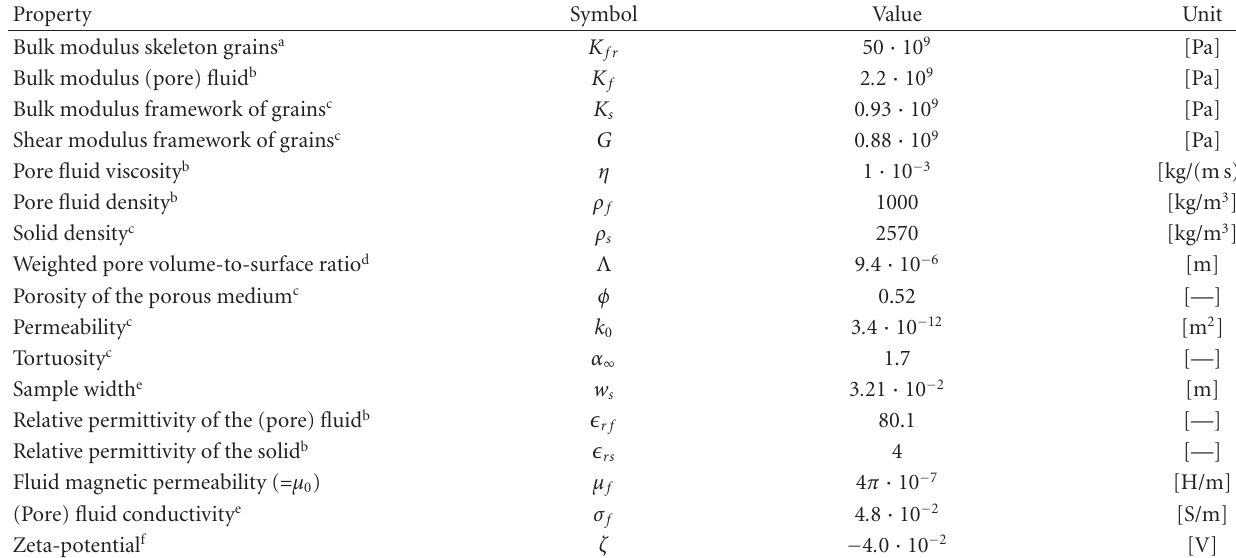
Table 2: (Modified from [44].) Parameters of the poroelastic medium and fluid layer. The temperature is 293.15 K. Property